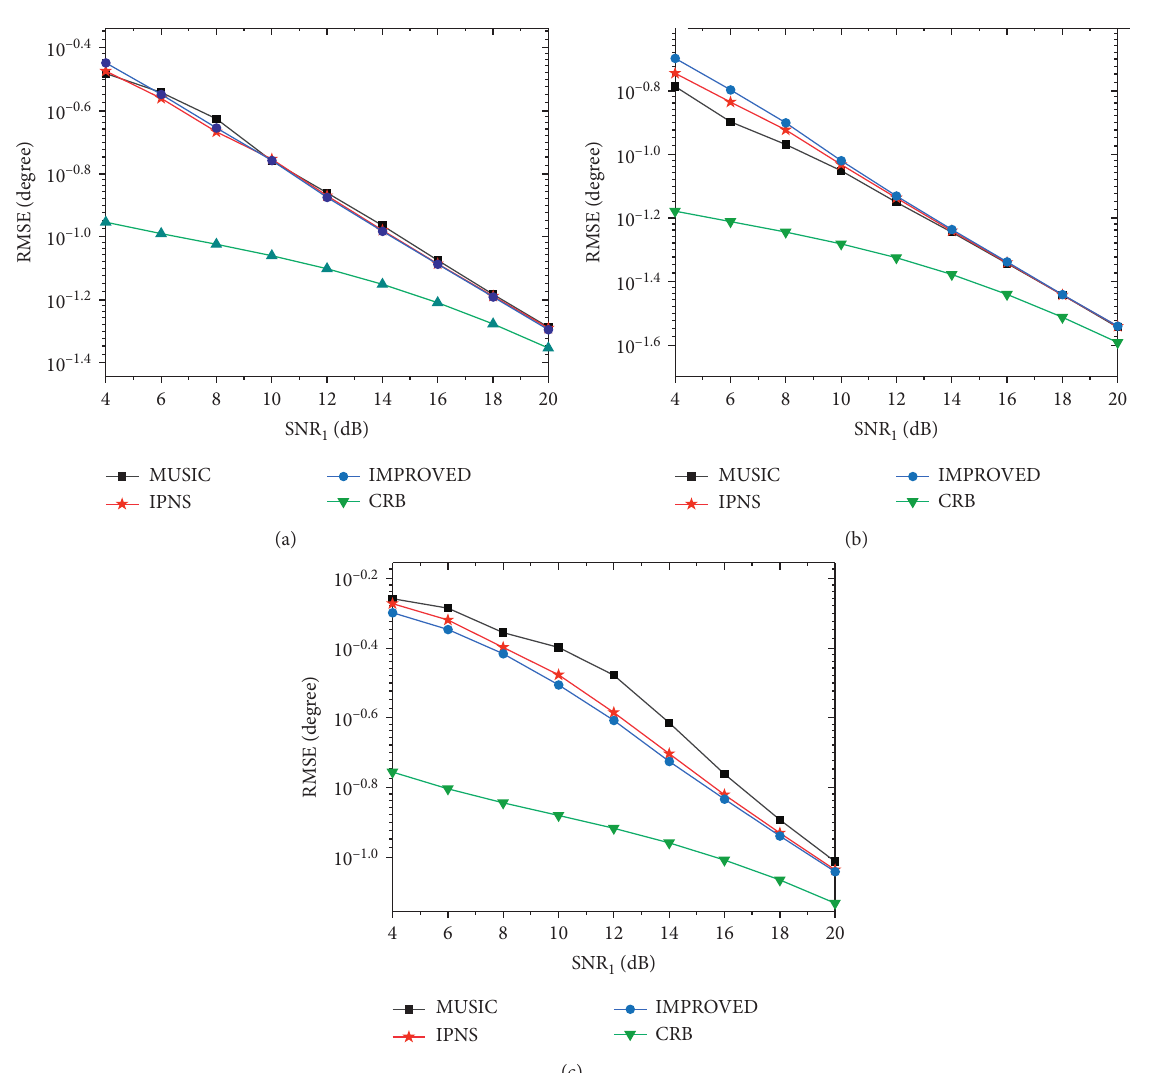
Figure 11: The RMSE of source 2 against SNR